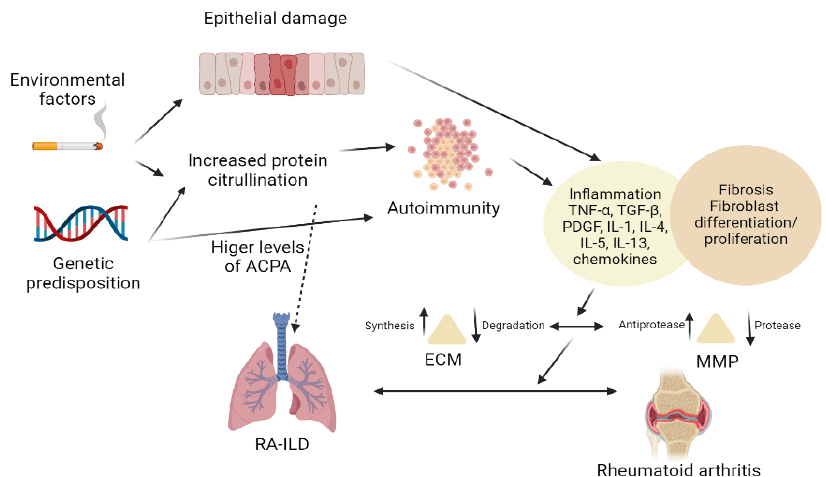
Figure 1. Pathogenesis of